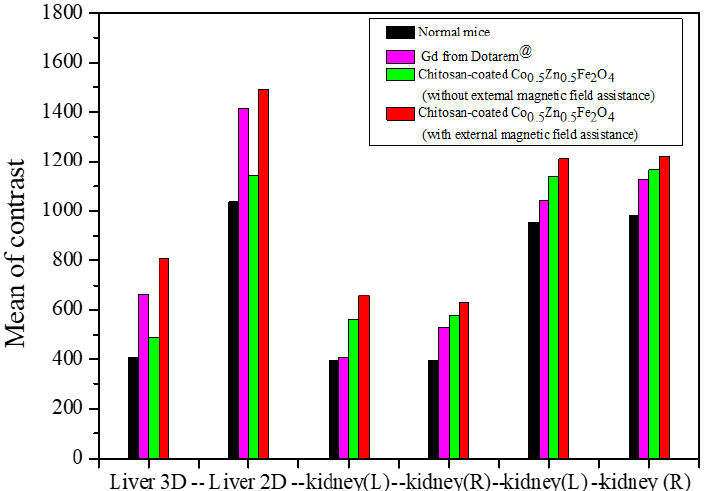
Figure 8. Mean of contrast histogram inferred from 3D and 2D MRI images of mice liver and kidneys from normal mice (black), mice injected with gadolinium (pink), mice injected with chitosan-coated Co 0.5 Zn 0.5 Fe 2 O 4 nanoparticles without external magnetic field assistance (green), and mice injected with chitosan-coated Co 0.5 Zn 0.5 Fe 2 O 4 nanoparticles with 400 mT of external magnetic field assistance (red).